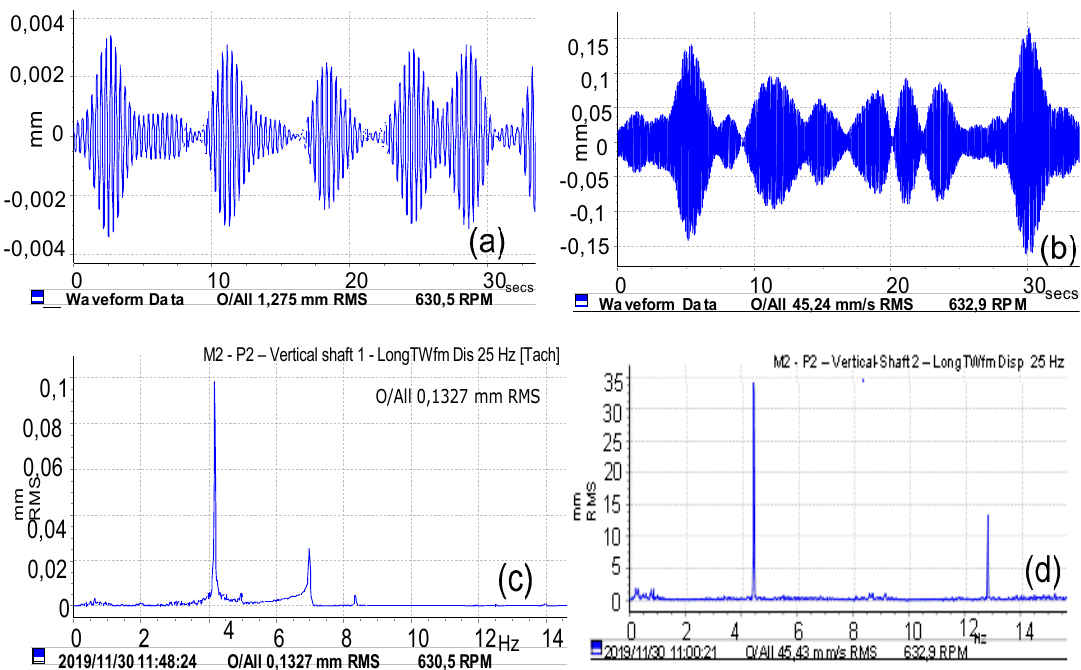
Figure 8. Experimental response of the lateral-torsional Cardan shaft: ( a , b ) lateral deflection of shaft 1 and shaft 2, and ( c , d ) frequency spectrum of the drive and driven